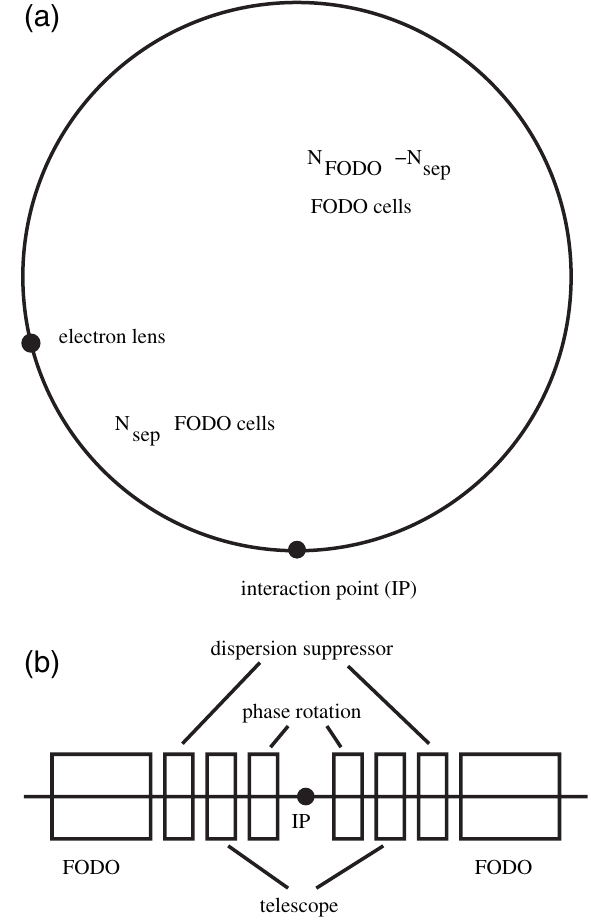
FIG. 1. Schematic drawings of the model electron ring (top) with interaction point (IP) and electron lens connected by two (cid:4) N and N identical FODO cells. arcs consisting of N sep FODO sep The bottom figure depicts a low- (cid:1) insertion with dispersion suppressors, low- (cid:1) telescopes, and phase-rotation